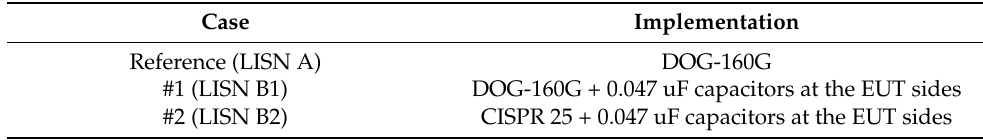
Table 2. LISN setups used to realize different working